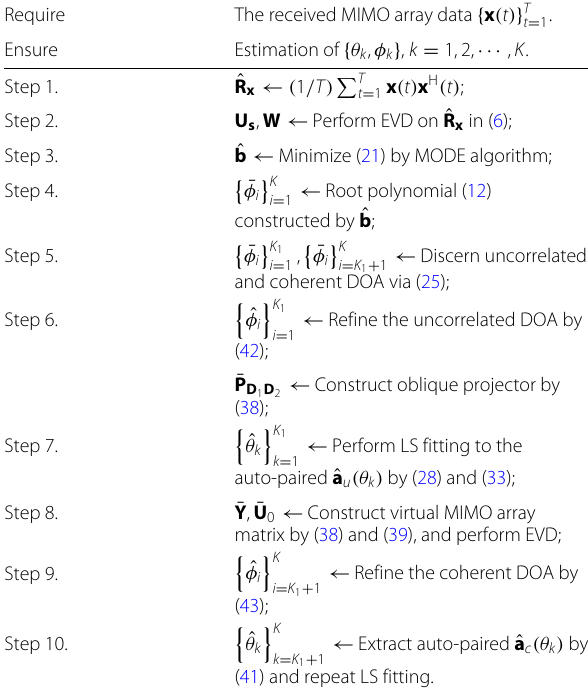
Table 2 Summary of the improved WSFOPDE